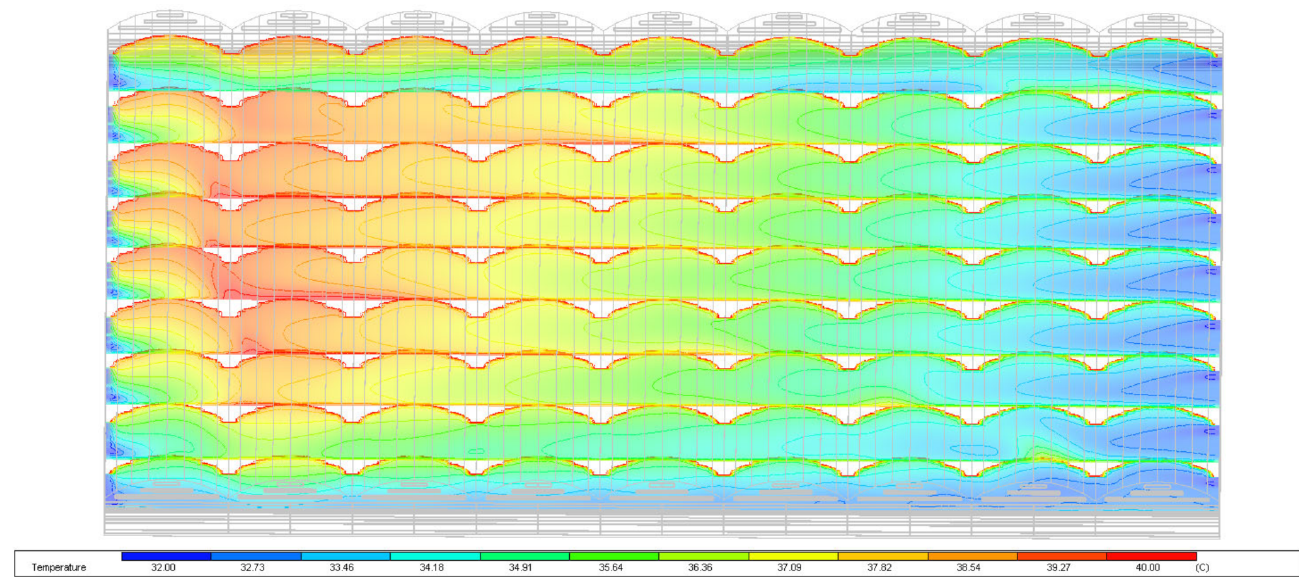
Figure 16. Temperature cloud map of the multi-span round-arch greenhouse (without an in- greenhouse ventilation channel) (outdoor wind speed 1m/s, outdoor temperature 32.7 ◦